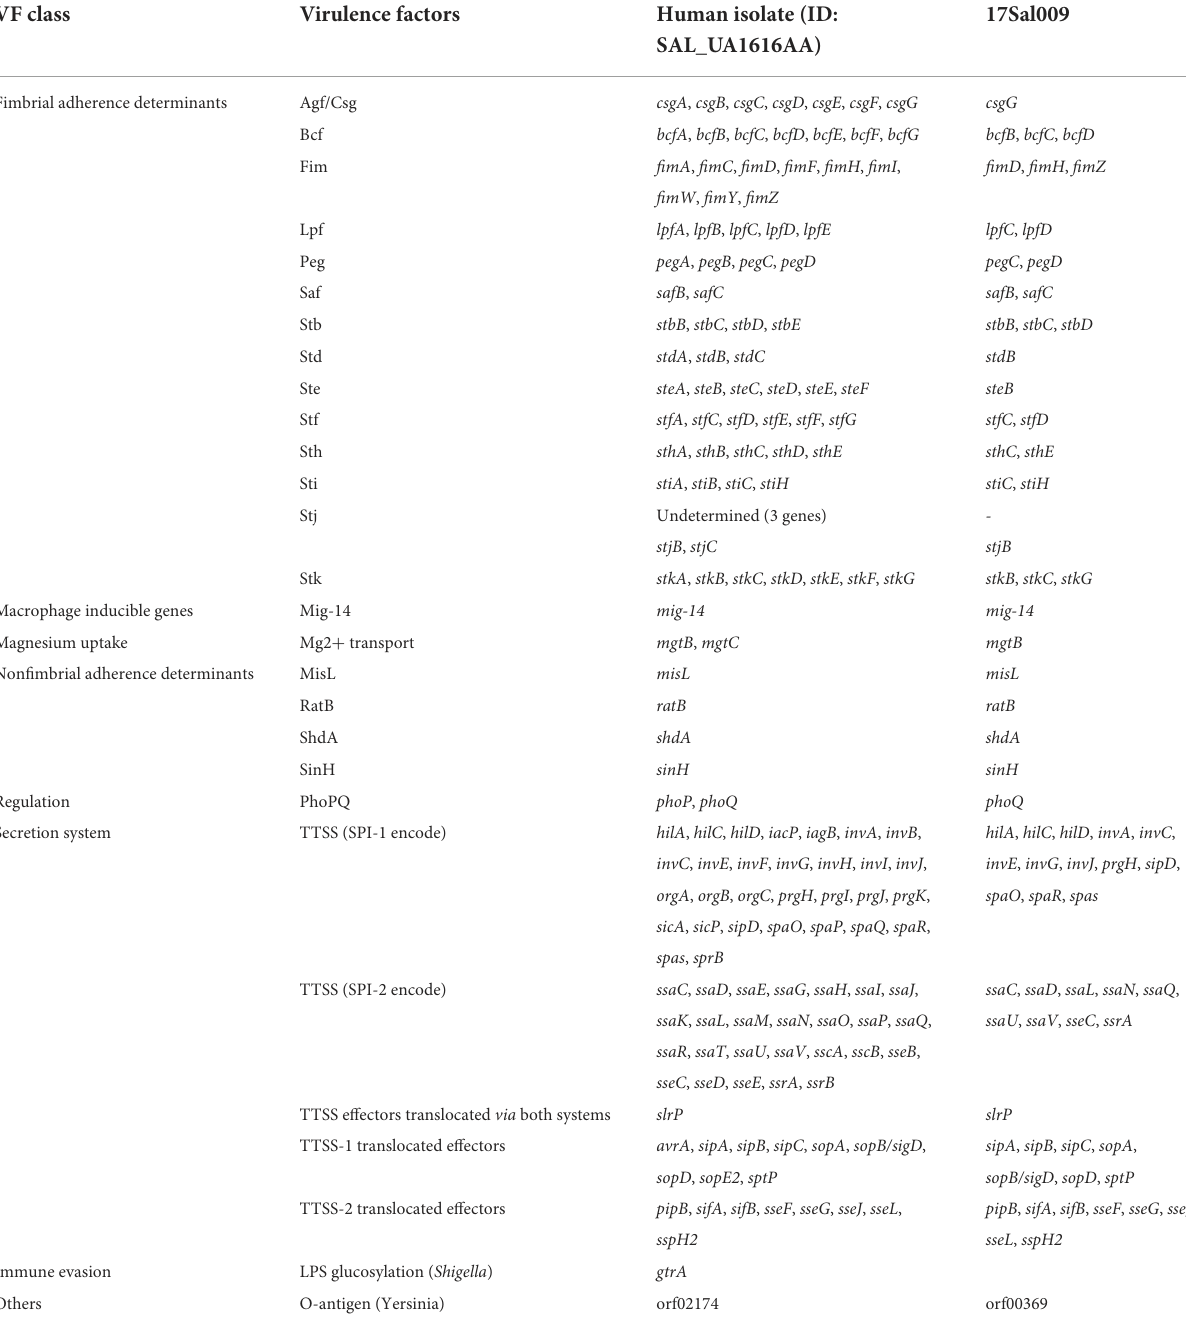
TABLE 2 Virulence genes predicted to exist in S. Thompson 17Sal009 and closely related human